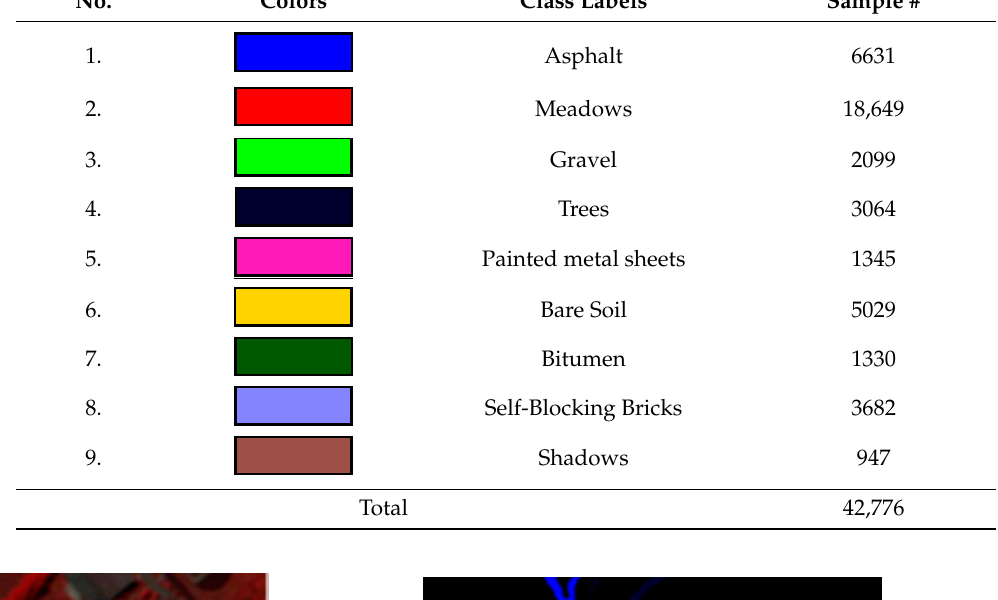
Table 4. The classification results of various DR methods on dataset Salina.